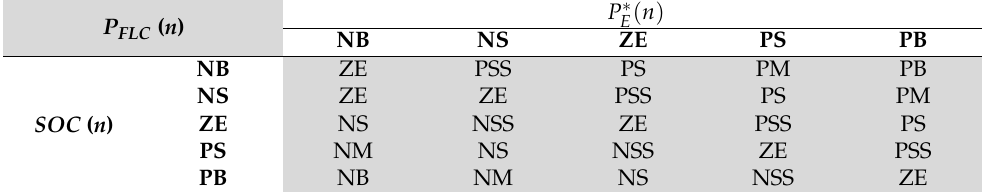
Table 4. Optimized rule base through Particle Swarm Optimization (PSO).